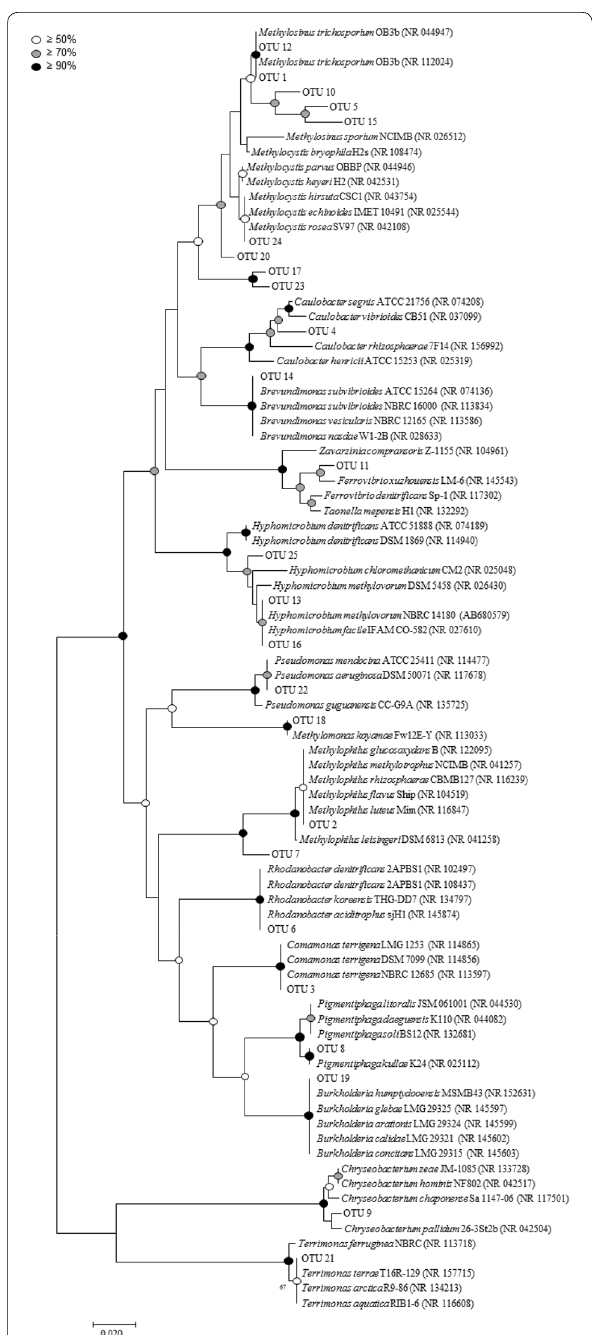
Fig. 3 Maximum composite likelihood phylogenetic tree for 25 OTUs affiliated to Proteobacteria and Bacteroidetes. Bootstrap values are represented as open white circles, 90% as black filled ≥